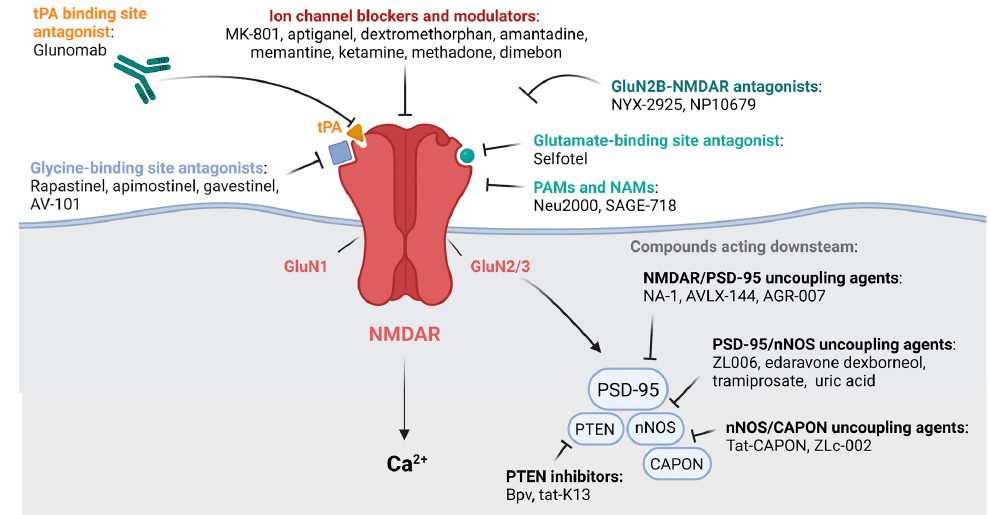
Figure 1. Pharmacological compounds targeting the NMDARs and their associated mechanisms. CAPON: Carboxy-terminal PDZ ligand of nNOS; PSD-95: postsynaptic density 95 kD protein; PTEN: phosphatase and tensin